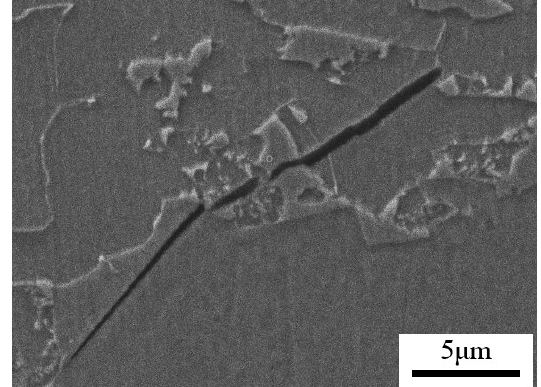
Figure 6. Typical secondary crack morphology of CGHAZ of test